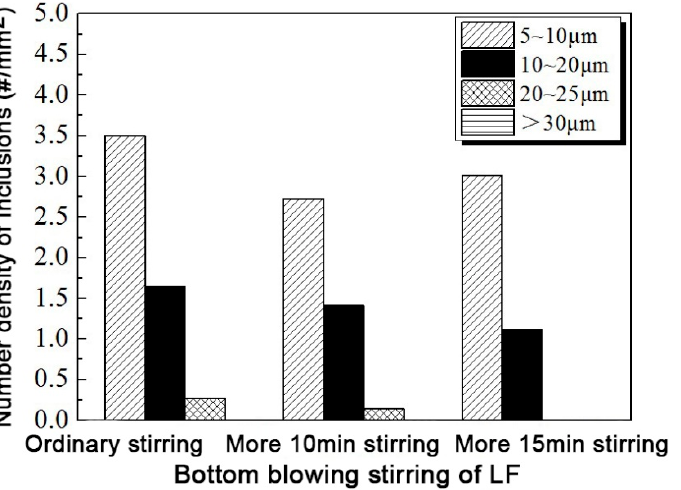
Figure 18. Size distribution of inclusions in casting slab after increasing weak stirring and holding period.